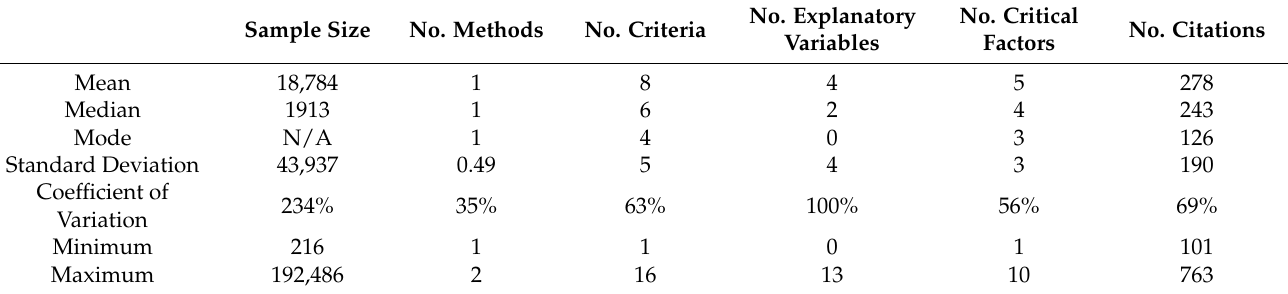
Table 3. Statistical measures applied to the articles with more than 100